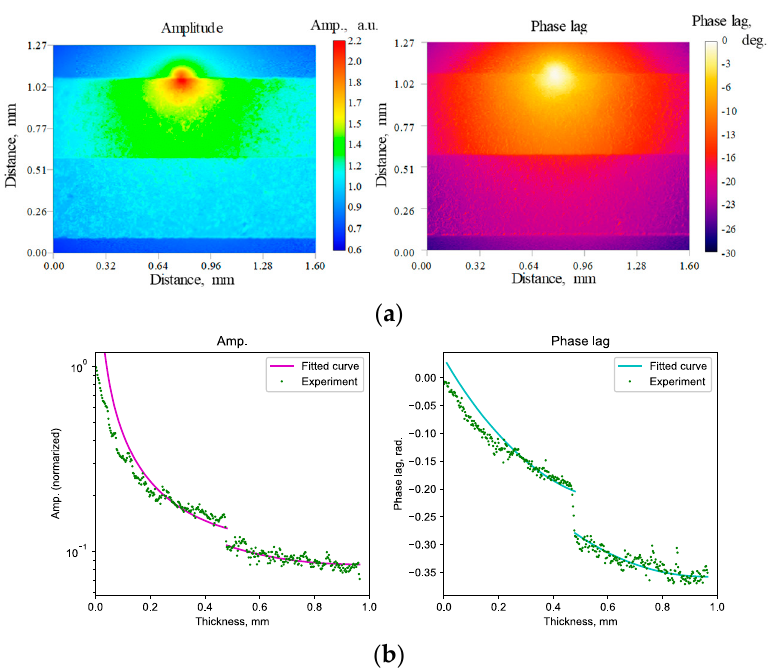
Figure 4. Amplitude and phase lag distribution and fitting analysis for TCR . ( a ) Amplitude and phase lag distribution in 1 Hz and 20 Hz heating. ( b ) Fitting results for amplitude and phase plag in 1 Hz and 20 Hz heating.